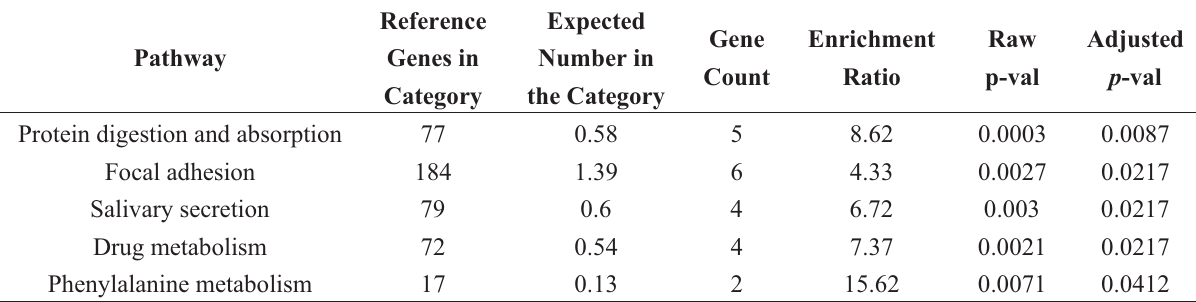
Table 5. KEGG pathway analysis of DEGs.